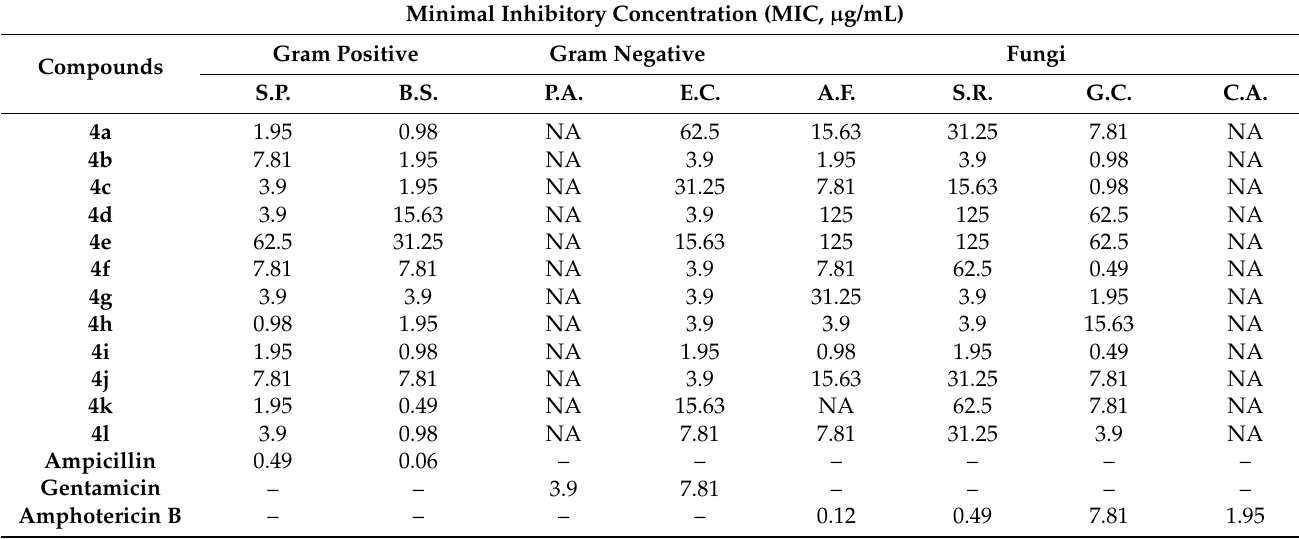
Table 3. Antimicrobial activity of the synthetic compounds (minimum inhibitory concentration (MIC), µ g/mL). Minimal Inhibitory Concentration (MIC, µ